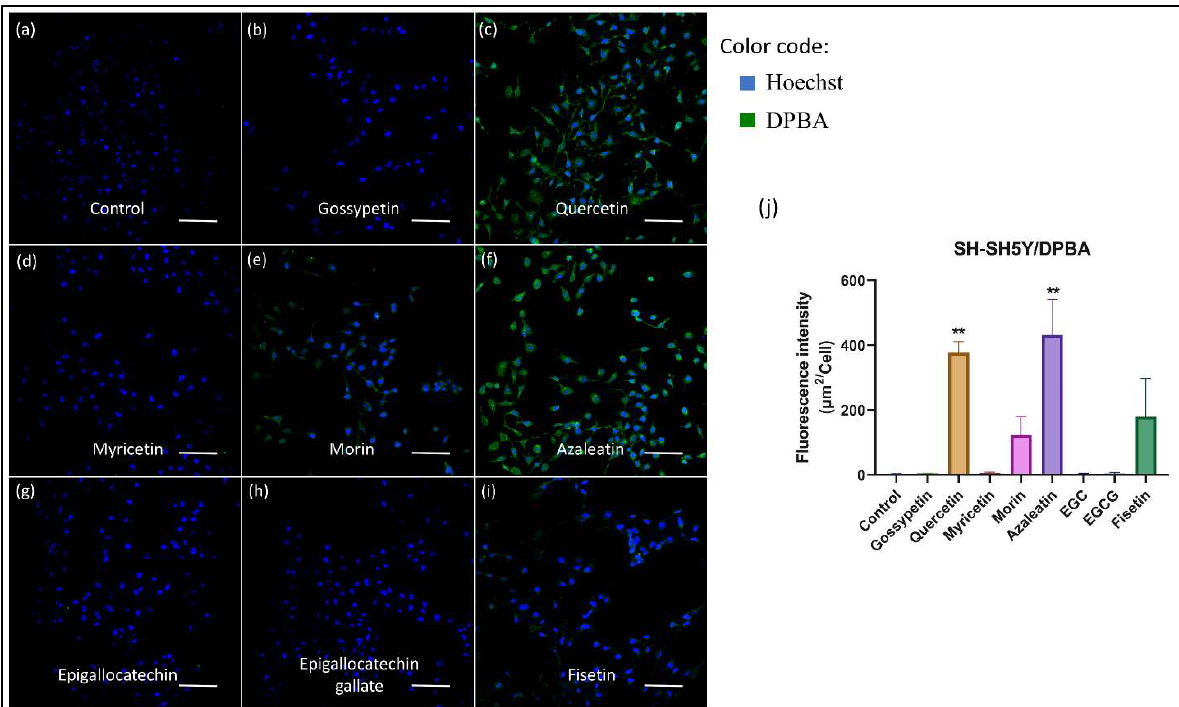
Figure 7. Fluorescence microscopic images (Ex. 470 nm) of human neuroblastoma (SH-SY5Y) cells after flavonoid uptake followed by DPBA treatment. Cells are treated with ( a ) DMSO (flavonoid absent, control), ( b ) azaleatin, ( c ) quercetin, ( d ) fisetin, ( e ) morin, ( f ) myricetin, ( g ) gossypetin, ( h ) epigallocatechin, and ( i ) epigallocatechin gallate. Flavonoid treatment (100 μM) is carried out for 1 h, while the enhancer DPBA solution (0.5% wt./ v , in ethanol) is employed for 10 min. The scale bars represent 100 μm. Nucleus was stained using Hoechst. Among these, the azaleatin, quercetin, fisetin and morin treated cells showed fluorescence while it was not detectable in gossypetin, epigal- locatechin, and epigallocatechin gallate treated cell. Panel ( j ) represents a comparison of fluorescence intensity exhibited by the flavonoid treated cells. The error bars represent the mean ± SEM. ** p < 0.01, one-way ANOVA followed by Tukey’s multiple comparisons test ( j